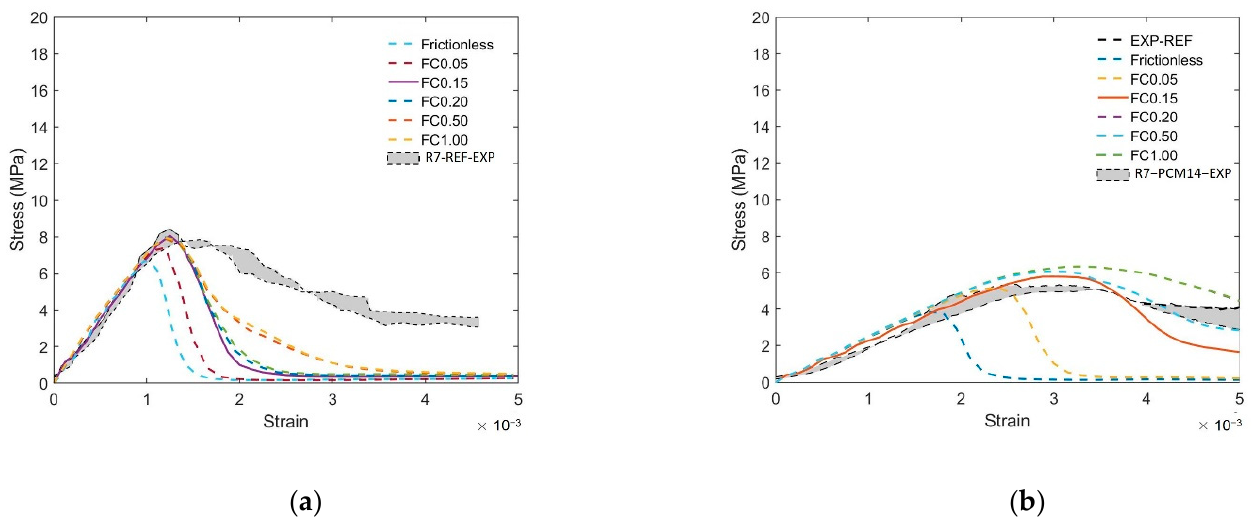
Figure 23. Influence of friction coefficient (FC) on the out-of-plane compressive behavior of ( a ) REF and ( b ) PCM14.